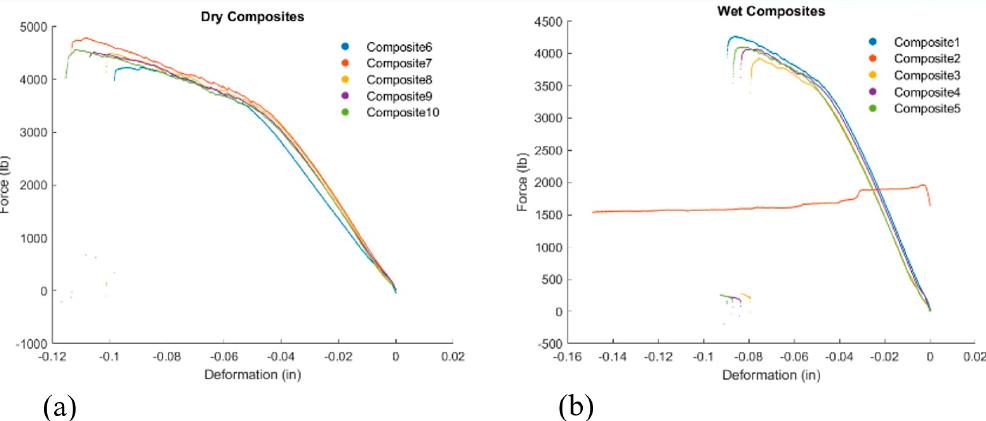
Figure 6. Force-displacement curves in longitudinal loading for ( a ) dry coupons and ( b ) saturated coupons.